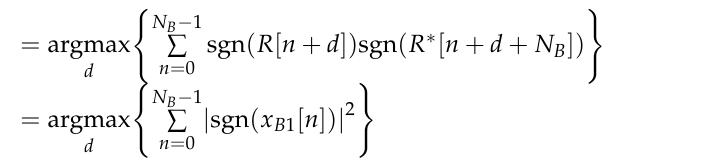
Table 1. Simulation system parameters. QPSK—quadrature phase shift keying; FFT—fast Fourier transform; OFDM—orthogonal frequency division multiplexing; SNR—signal-to-noise ratio.